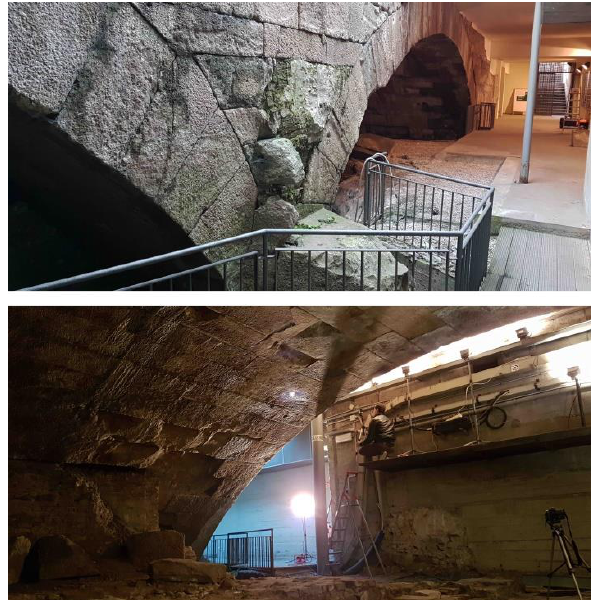
Figure 1. The Roman bridge of San Lorenzo: the first arch (above) and the central arch (below) where the chamber narrows and the light fades